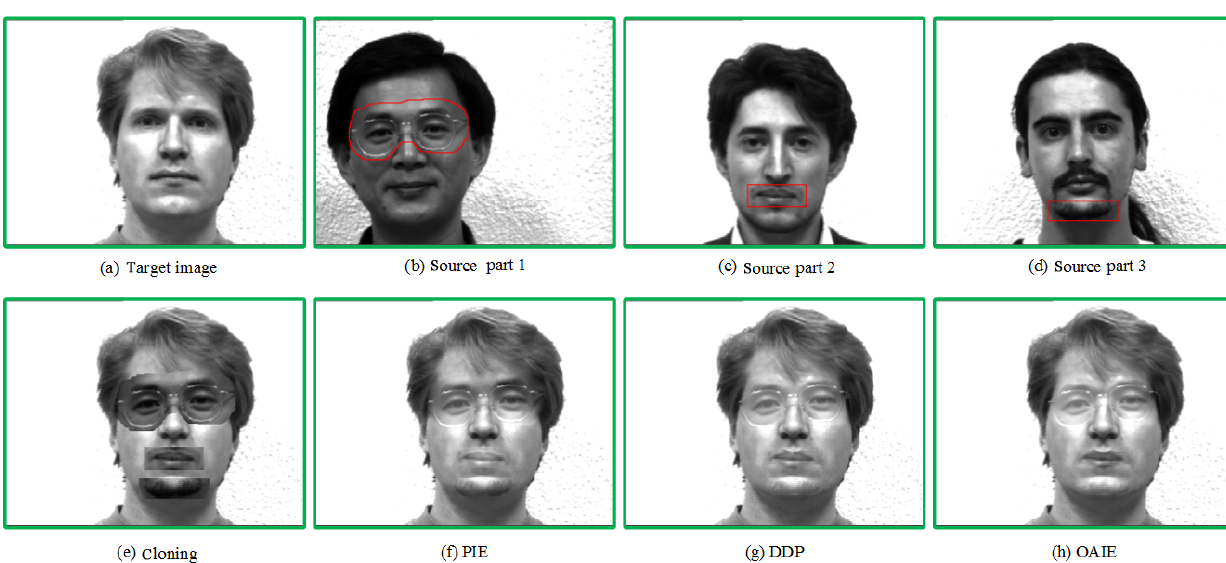
Fig. 7 Seamless stitching multiple target parts. Various structure or color artifacts (e.g., around the glasses and mouth) can be found in the results generated by the PIE and DDP methods, while the OAIE result is more natural.